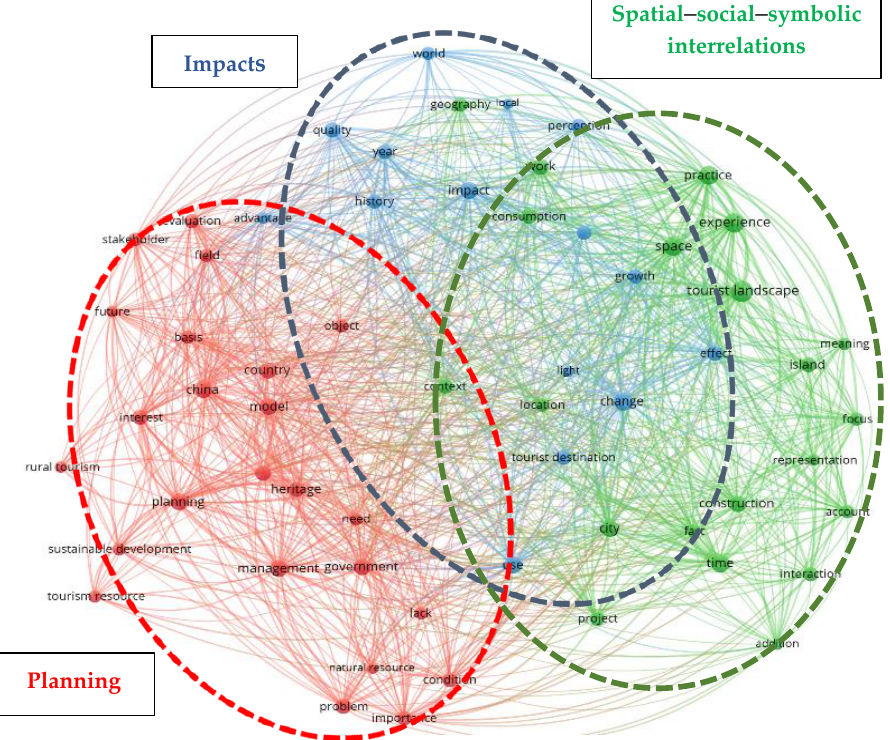
Figure 4. The co-occurrence term map with the three emerged clusters.